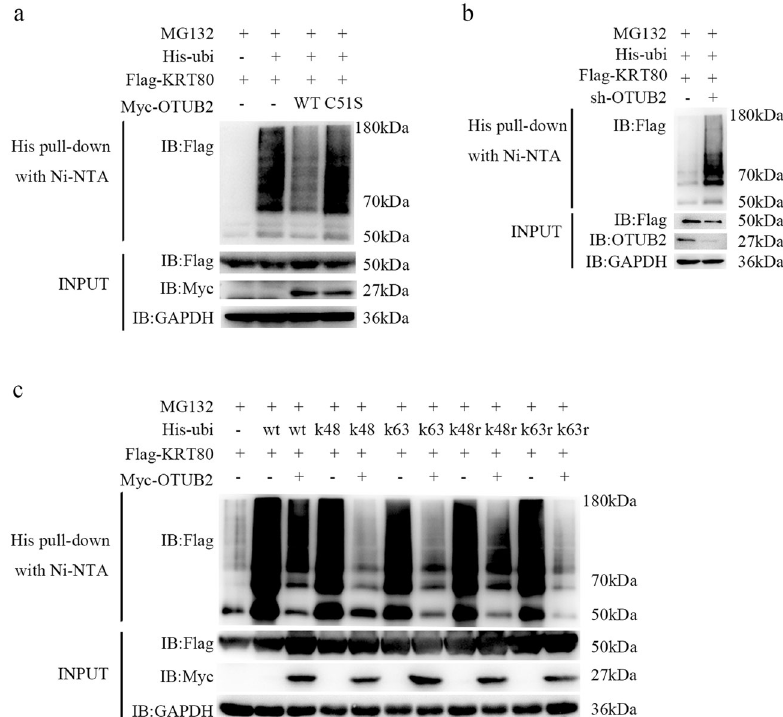
Fig. 5 OTUB2 stabilizes KRT80 through Lys-48-linked and Lys-63-linked deubiquitination. a HEK293T cells were co-transfected with Flag- tagged KRT80, Myc-tagged OTUB2 (WT), Myc-tagged OTUB2-C51S (C51S), and His-ubiquitin, and then treated for 4 h with 20 μ M MG132. As stated in the materials and methods section, the ubiquitin pull-down assay for Flag-tagged KRT80 was performed. b Roles of OTUB2 on KRT80 ubiquitination in AGS cells. Western blotting analysis showed polyubiquitination of KRT80. c Flag-tagged KRT80, Myc-tagged OTUB2 were co- transfected into HEK293T cells with His-ubiquitin and its mutants Lys-48 only, Lys-63 only, Lys-48r, and Lys-63r. Cell lysates were collected and ubiquitinated. KRT80 was observed using western blotting after being pulled down with nickel-nitrilotriacetic acid beads. The data re fl ect a minimum of three independent